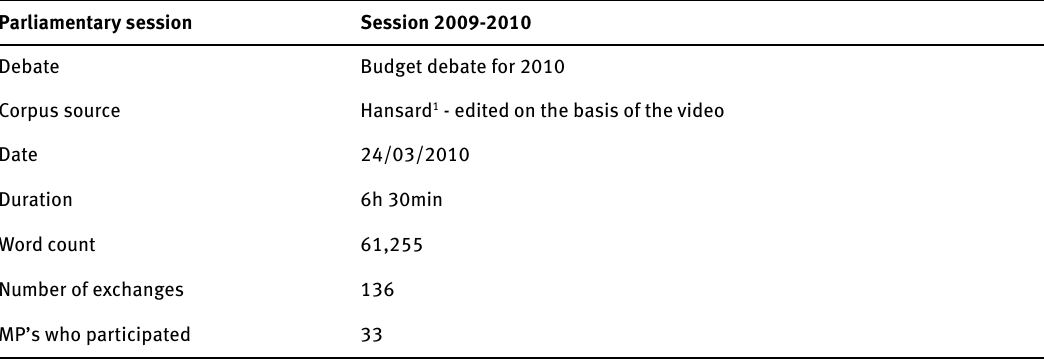
Table 1: Details of the